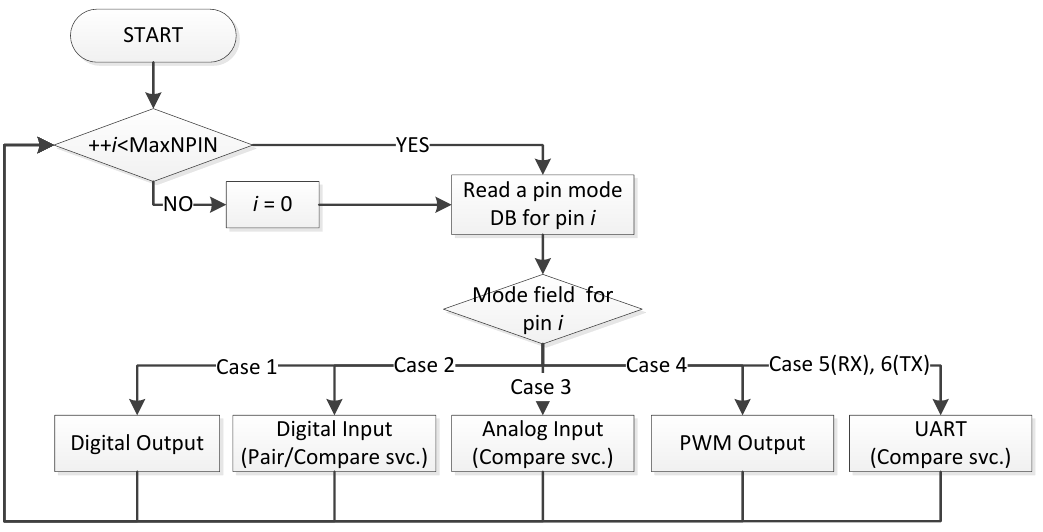
Figure 3. Overview of the Control